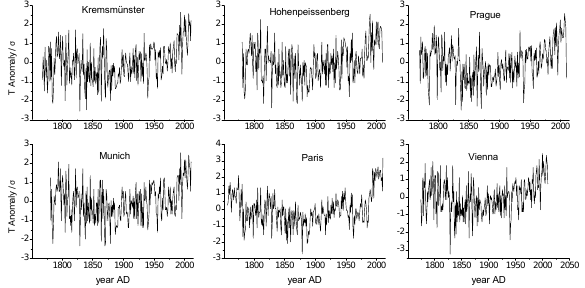
Fig. 1. Long-term temperature records from six central European stations.